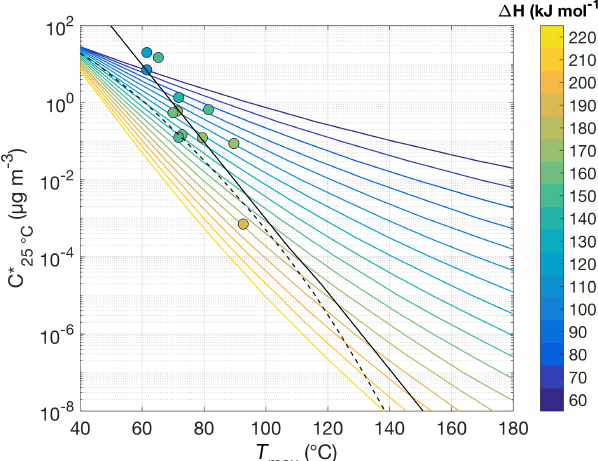
Figure 7. The relationship between T max (abscissa) and both the saturation concentration C ∗ at room temperature (ordinate) and the vaporization enthalpy (cid:49)H (color scheme). Results from model sim- ulations are summarized by the colored lines. Typical assumptions and parameters were used: α = 1, τC W = 8 . 77mgm − 3 , D P , 0 = 200nm, and temperature ramp rate = 0 . 14Ks − 1 . Experimental ob- servations by Lopez-Hilfiker et al. (2014) are shown as colored cir- cles; their fit by Mohr et al. (2017) is shown as a black line. The dashed black line depicts the semi-empirical C ∗ – (cid:49)H relation de- veloped by Epstein et al. (2010): (cid:49)H = 131 − 11log 10 (C ∗ ) .